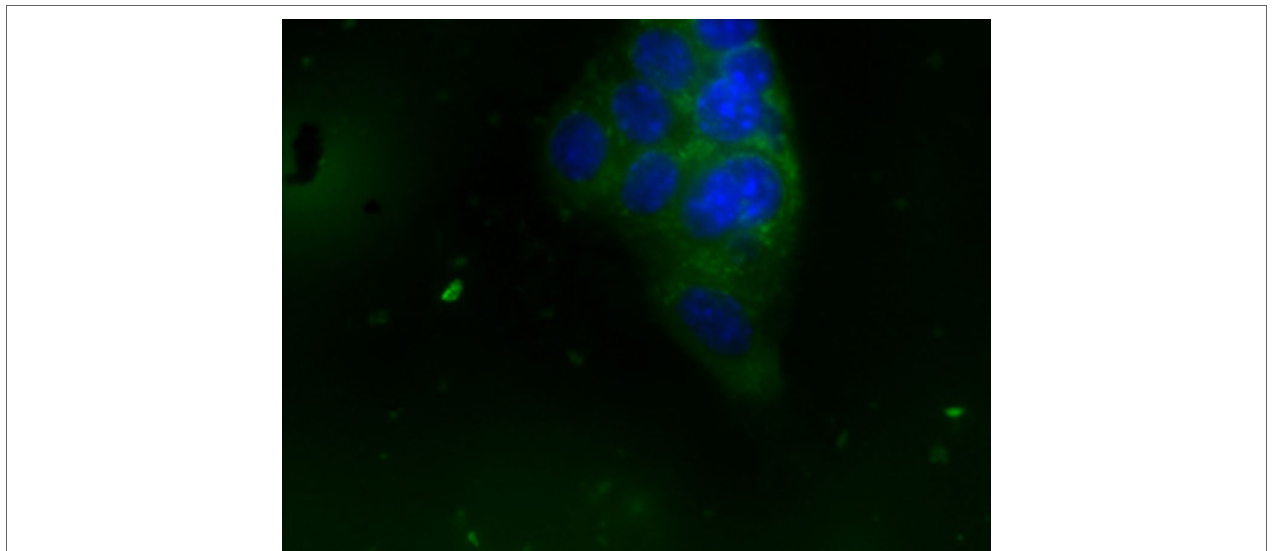
FIGURE 9 | OLNB internalization by TUBO cell line. Cell nuclei after DAPI staining (in blue; OLNBs, in green). Magnification